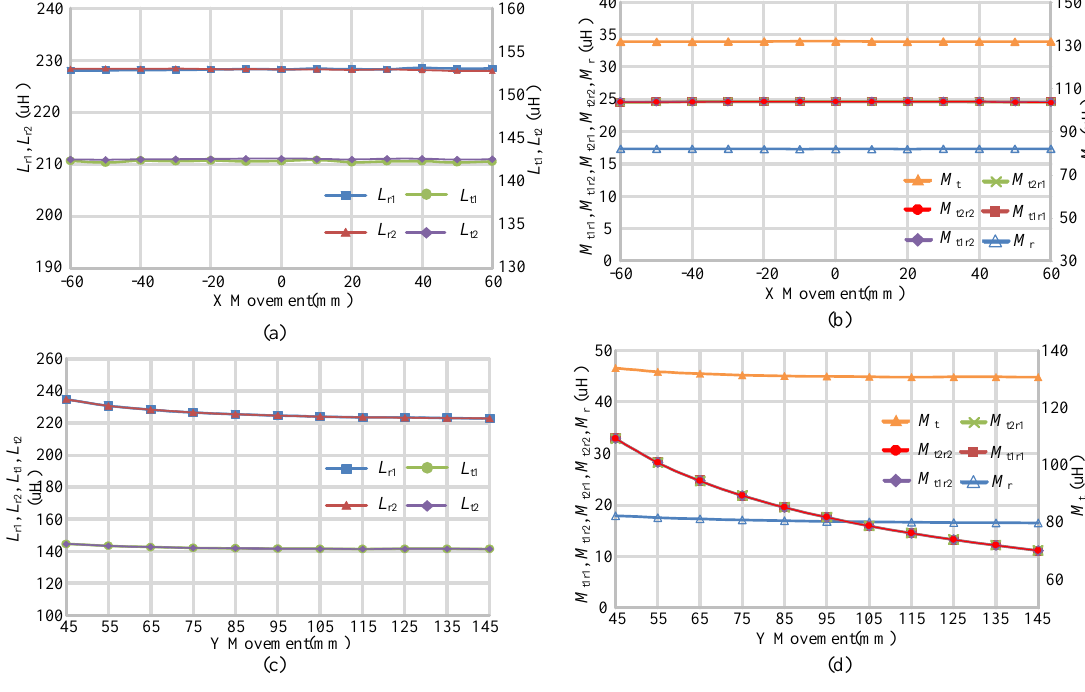
Figure 3. Inductance variations with misalignments: ( a ) inductances of the coils with x -axis misalignment; ( b ) mutual inductances of the coils with x -axis misalignment; ( c ) inductances of the coils with y -axis misalignment; ( d ) mutual inductances of the coils with y -axis misalignment.